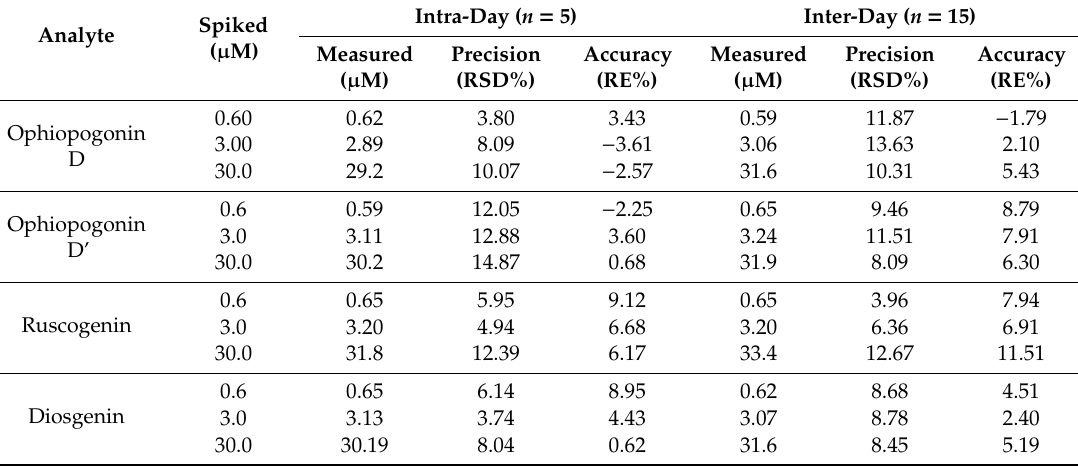
Table 3. The intra-day and inter-day precision and accuracy for UPLC-MS / MS assay of ophiopogonins in fermented broth of human gut